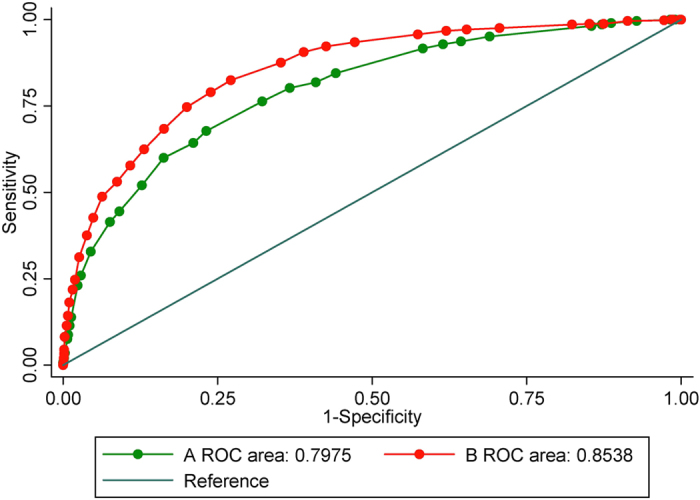
Receiver operating characteristic curve for the symptom-based questionnaire.(A) the traditional eight-item questionnaire; (B) the revised eleven-item questionnaire.